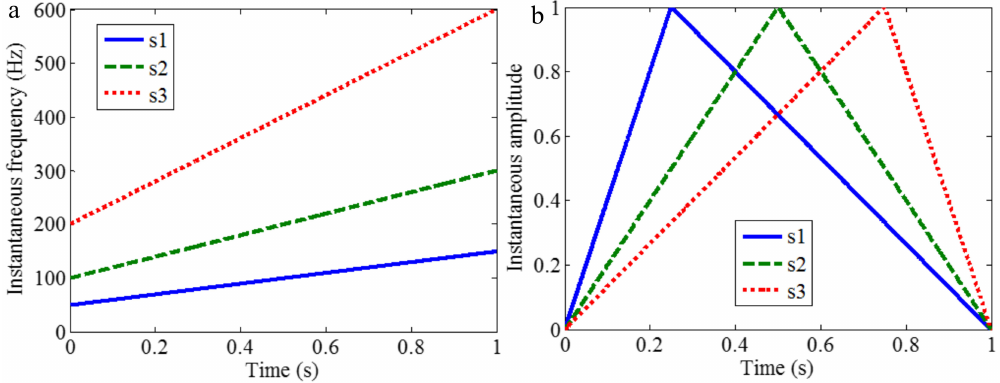
Figure 28. The IF and IA of the sample signal f sig 6 : ( a ) IF and ( b )